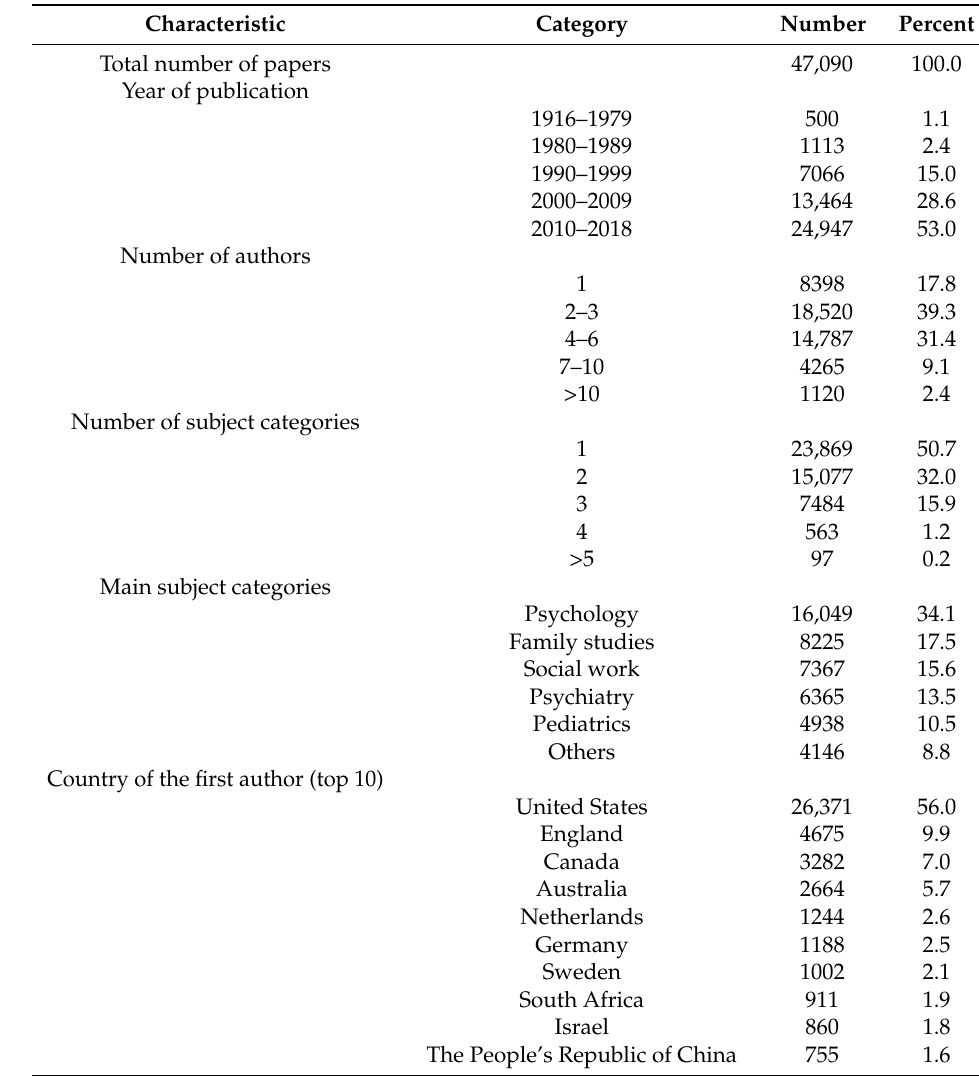
Table 1. Characteristics of selected